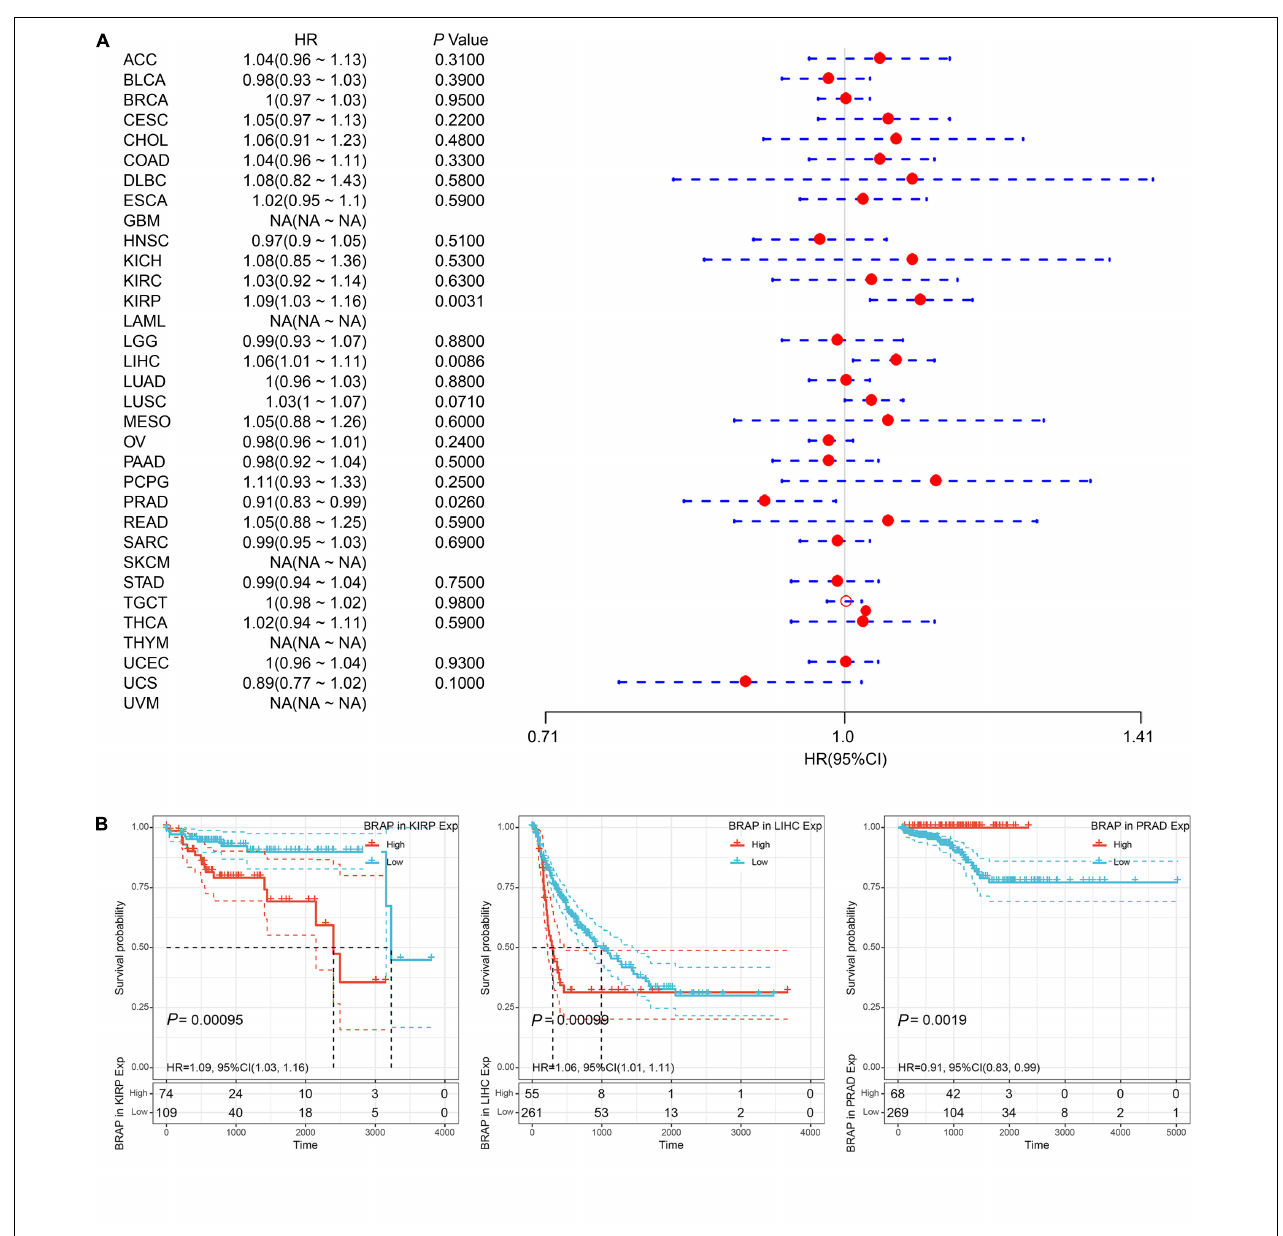
FIGURE 4 | Relationship of BRAP expression with patients’ DFI. (A) Forest plots of hazard ratios of BRAP in 33 cancer types. (B) Kaplan–Meier DFI curves for patients stratified by different expression levels of BRAP in KIRP, LIHC, and PRAD.